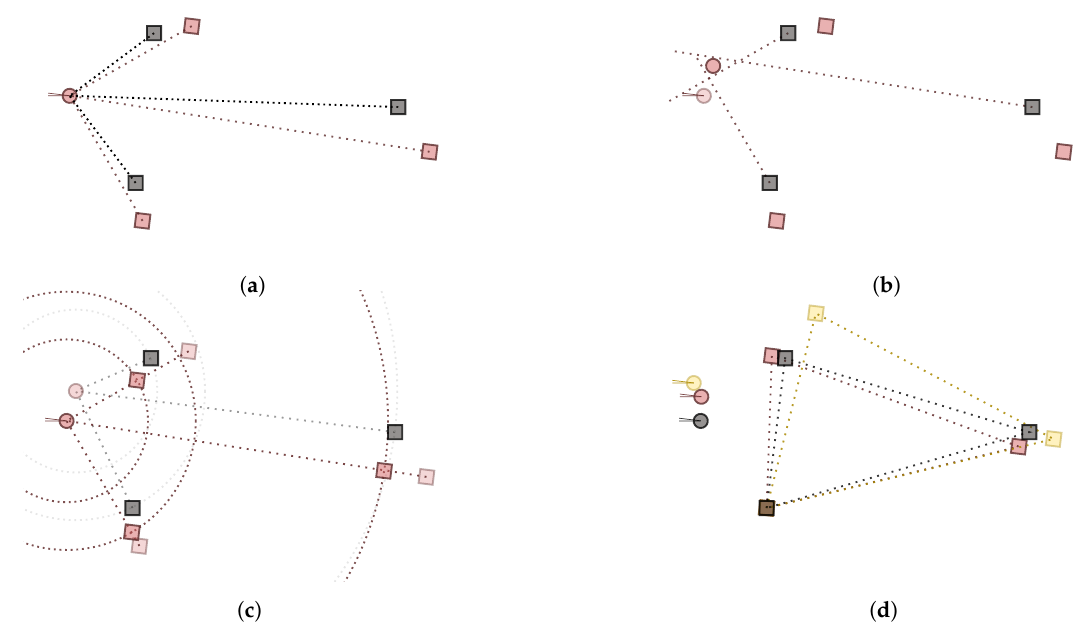
Figure 3. Line fit model attempts to determine the receiver location by finding the closest points for Direction-of-Arrival (DoA) lines going through reference source positions. ( a ) Sound source with system delay and rotated mic array. ( b ) Least squares line fit assuming that the DoAs and reference source positions are right. ( c ) The measurement system delay is approximated from the distance between the reference source positions and the approximated receiver position. ( d ) The final fit returns a geometry closer to the reference